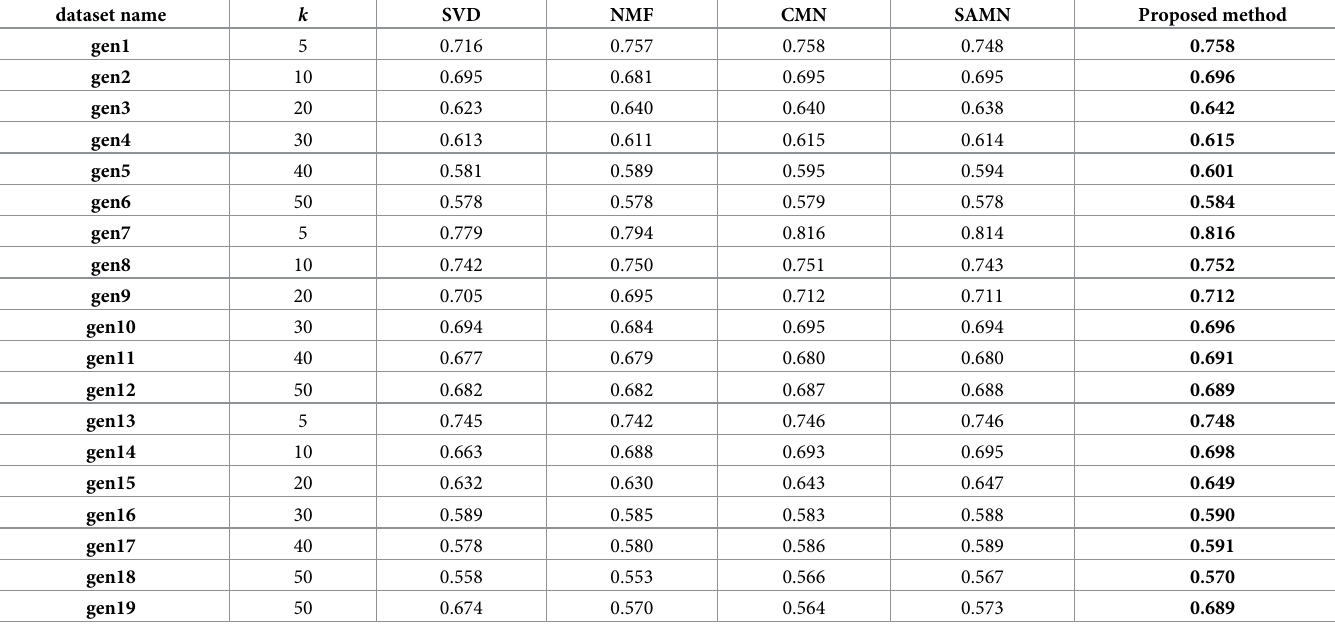
3.2.2 Experimental results. In this work, nineteen datasets are evaluated to study the three different data distributions and different sizes of the datasets. Table 10 shows the experi- mental results of all datasets by using nDCG. From Table 10, the proposed method obtained the highest nDCG results when compared with the baselines in terms of the ranking list. Table 10. The nDCG experimental results of synthetic data.